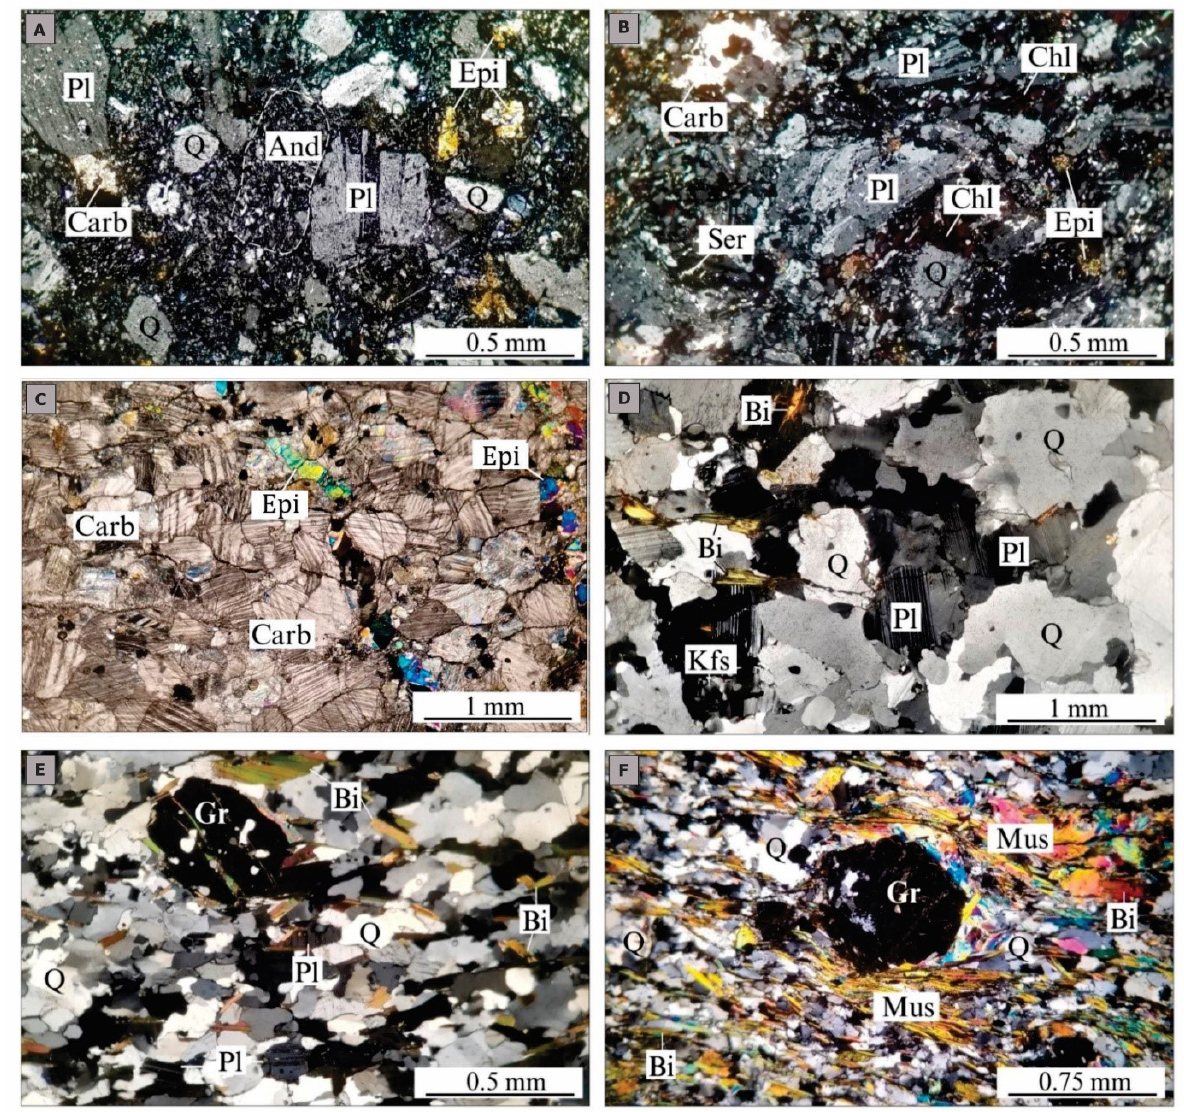
Fig. 5. Representative microphotographs of rocks from the Alagbayan area. A) Sandstone (sample SM26-2), B) Metabasalt (sample SM26-6), C) Limestone (sample SM27-11), D) Granite (sample SM26-7), E) Garnet-biotite gneiss (sample SM27-1), F) Garnet-biotite-muscovite schist (sample SM27-4). Abbreviations: Q - quartz, Pl - plagioclase, And - andesite, Carb - carbonite, Epi - epidote, Chl - chlorite, Ser-sericite, Cal - calcite, Kfs - K- feldspar, Bi - biotite, Gr - garnet, Mus - muscovite. All photomicrographs are under cross-polarized